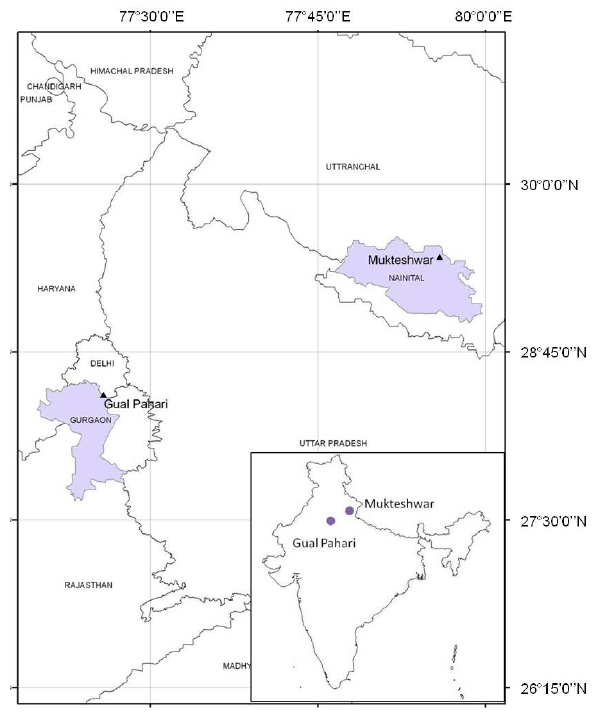
Fig. 1. Map of the measurements